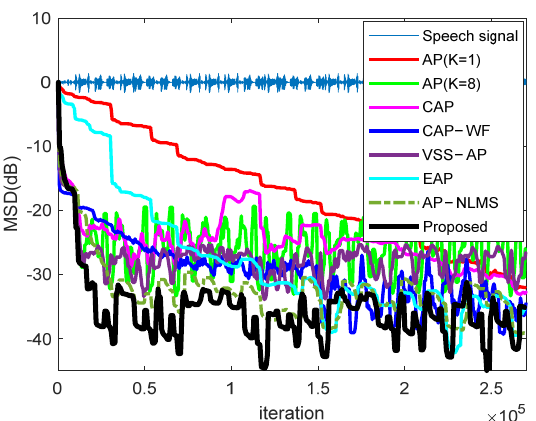
Figure 13. Comparison of the performance of different algorithms in echo cancellation.